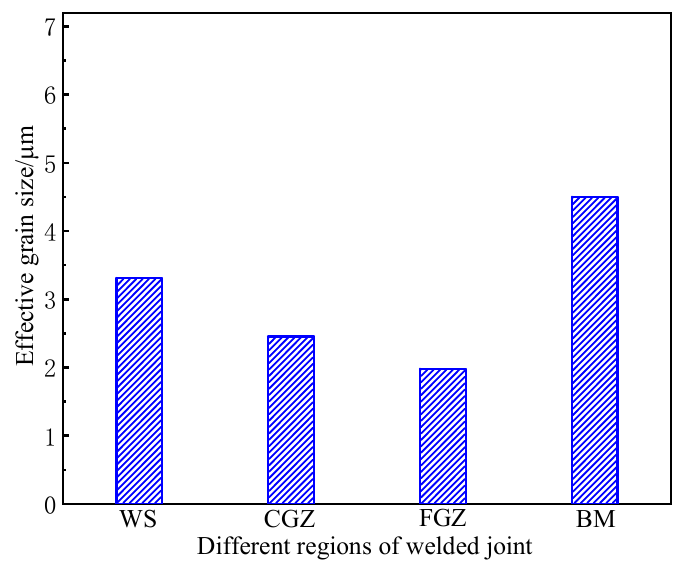
Figure 12. Effective grain size of each region.